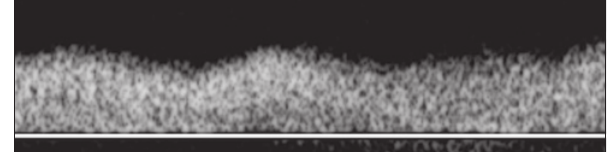
Figure-1: Pulsed-wave Doppler image of monophasic waveform of a portal vein as an